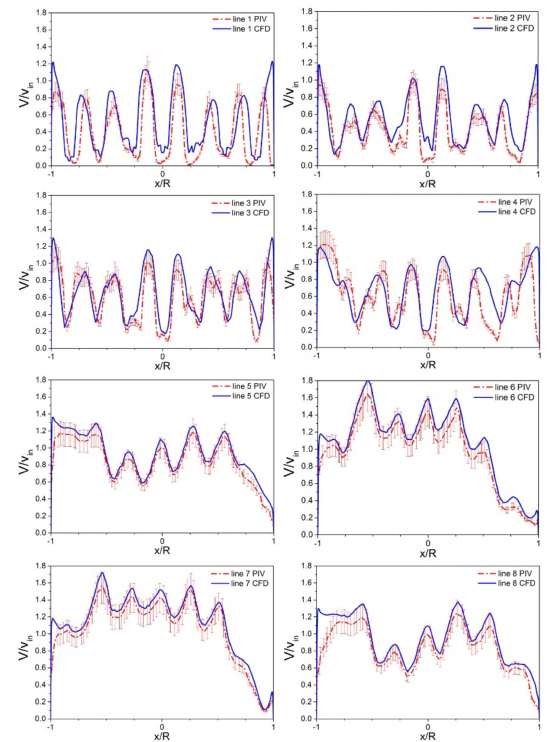
Figure 15. Comparison of velocity profiles derived by CFD method and gained from PIV for Q = 7.5 m 3 / h.